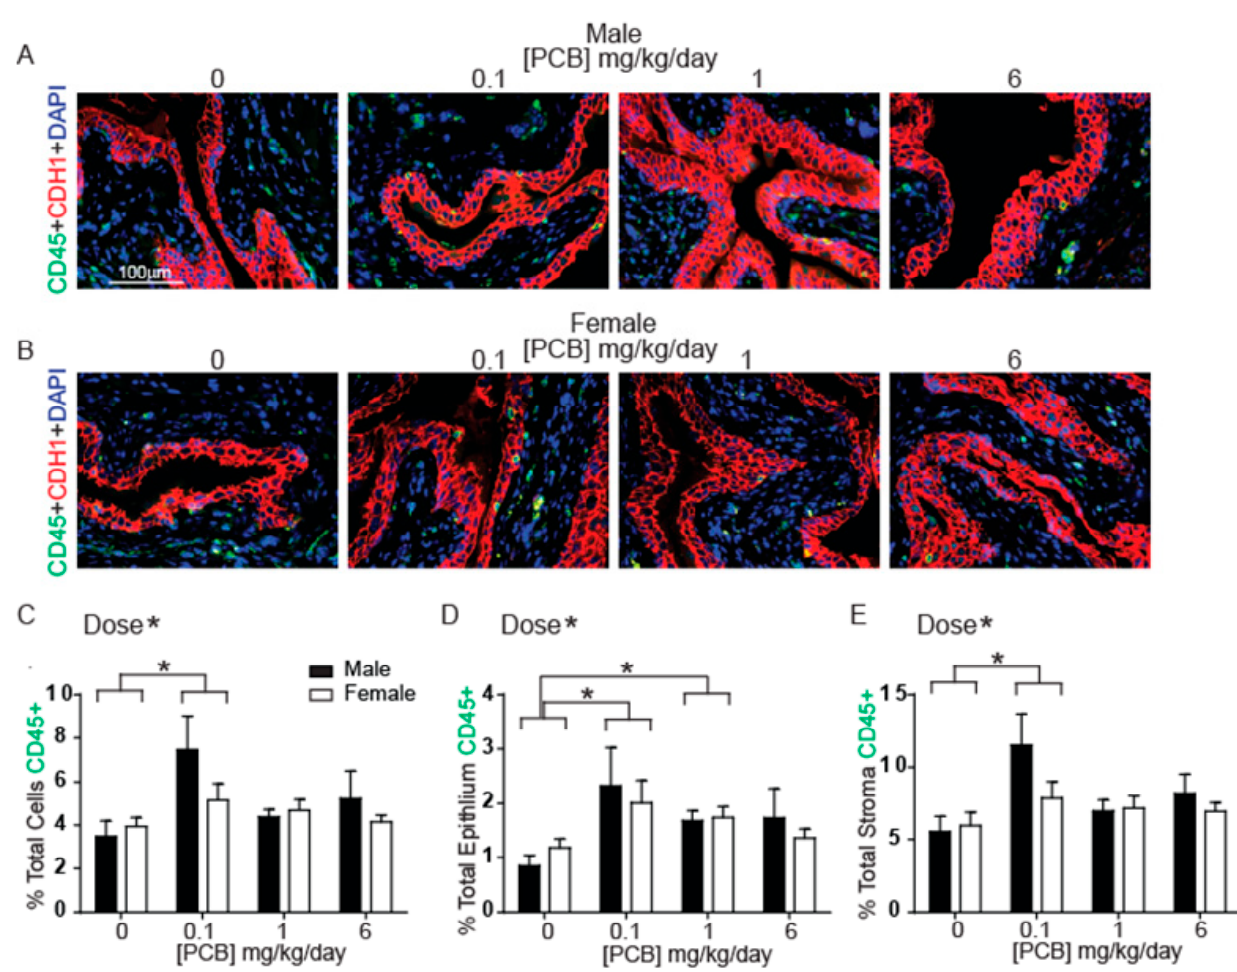
Figure 1. PCBs increase CD45-positive immune cells in bladder of developmentally exposed mice. Mice were exposed to PCBs via maternal diet through gestation and lactation and bladders collected from young male and female offspring at postnatal day (P) 28–31 for immunohistochemistry. Representative images of ( A ) male and ( B ) female mouse bladders at each PCB treatment group incubated with antibodies targeting CD45 (green) to label immune cells, e-cadherin (CDH1, red) to label all epithelium and DAPI (blue) to stain nuclei. Quantification of ( C ) the percent of total cells CD45 positive, ( D ) the percent of total epithelial cells CD45 positive and ( E ) the percent of total stromal cells CD45 positive. Results are the mean ± SEM, n = 4–6 bladders per treatment group, up to 3 images per bladder were averaged for final value. Significant differences at p < 0.05 are indicated by asterisk or asterisk and bars, as determined using two-way ANOVA followed by Tukey’s multiple comparisons tests.